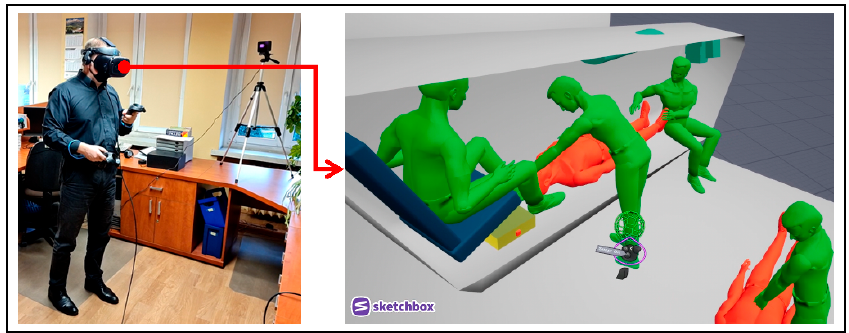
Figure 9. Example of using Virtual Reality to edit and visualize the obtained results.